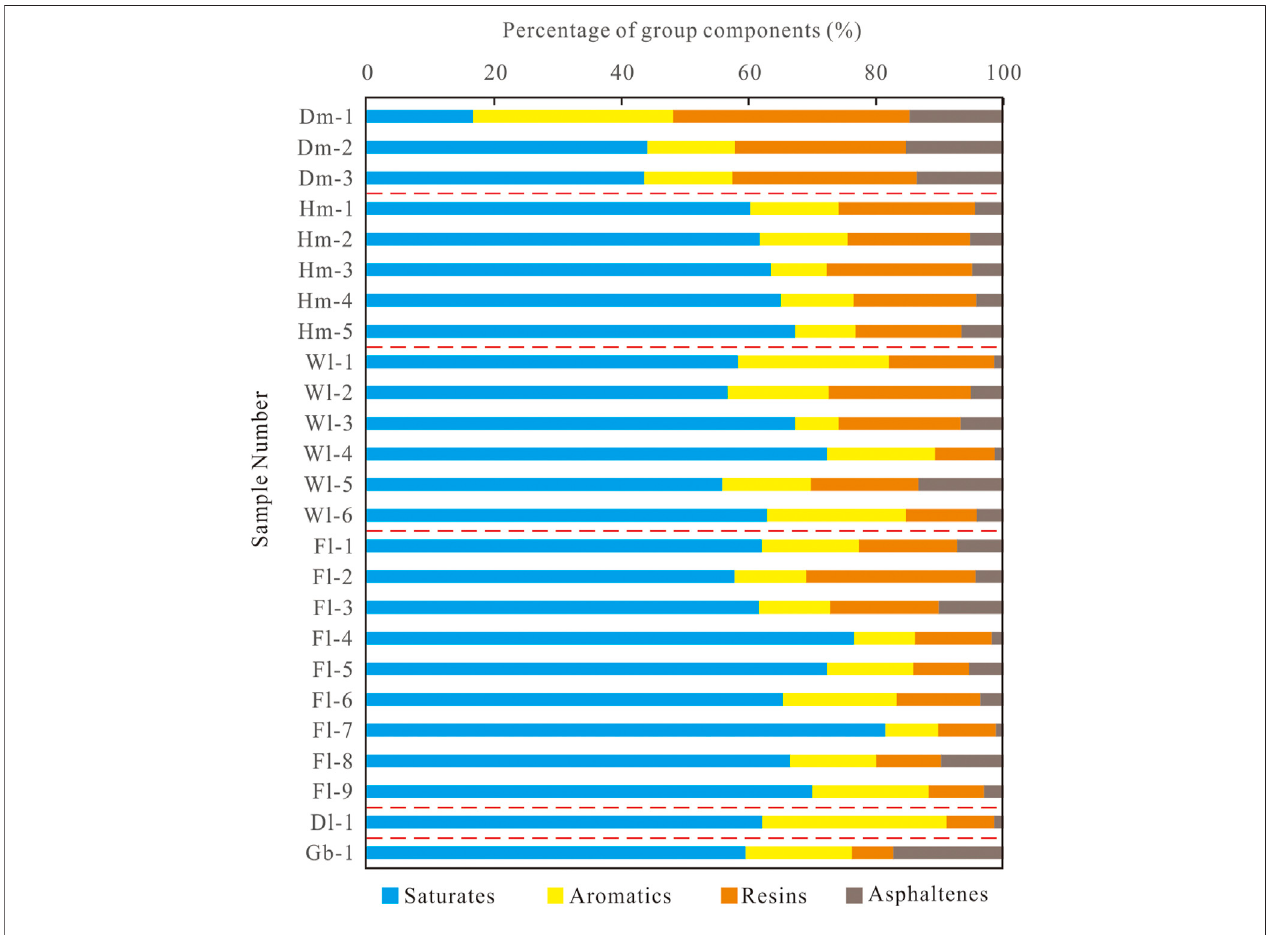
FIGURE 8 | Percentage of group components in shales with different